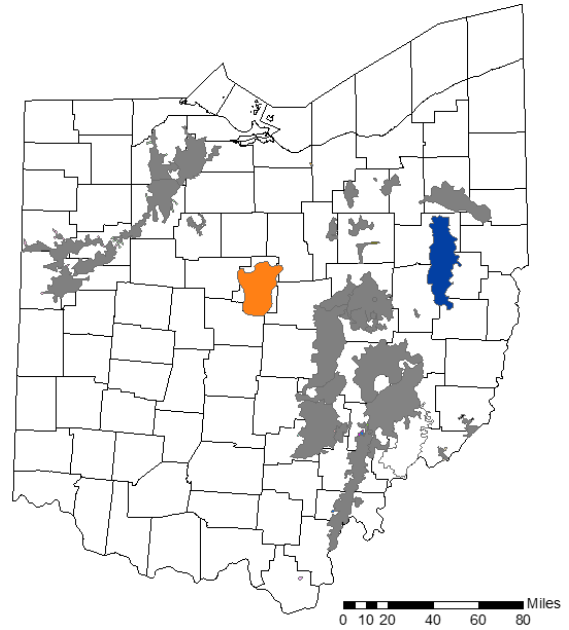
Figure 1. Locations of the Morrow Consolidated (orange) and East Canton (blue) oilfields in Ohio. The grey regions represent other major oilfields in Ohio (after Hawkins et al.).